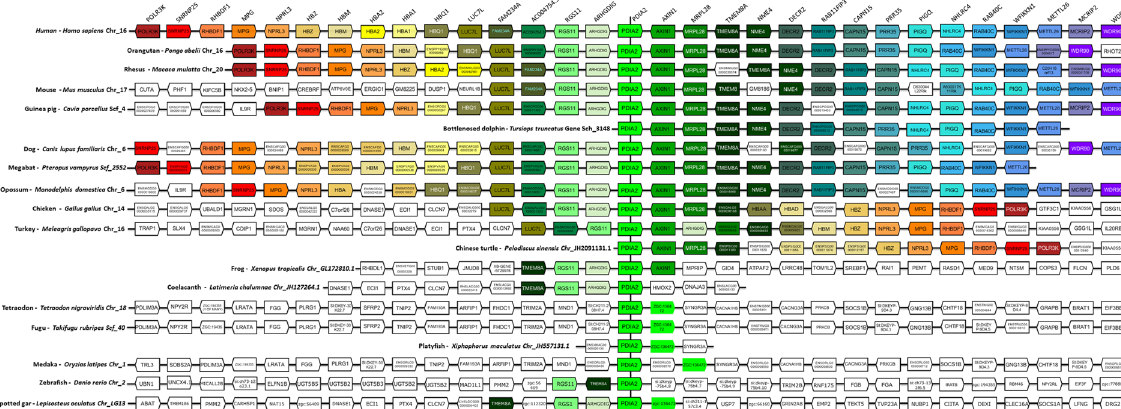
Figure 4. Alignment of the genomic region containing PDIA2 /RhoGDI γ cluster in vertebrates. Gene names and positioning are based upon the Genomicus database (see methods). All species are aligned against Homo sapiens . The map is centralized in PDIA2/RhoGDI γ (ARHGDIG) gene pair. Genes are aligned in columms and kept in the order in which they appear in chromosomes (Chr) and scaffolds (Scf), without consideration for distance, while the transcriptional sense is represented by the pentagon tip. All orthologs are drawn with the same color and the lettering on the top refers to the Homo sapiens genes. In addition to the main genes of interest, the neighboring genes are included for